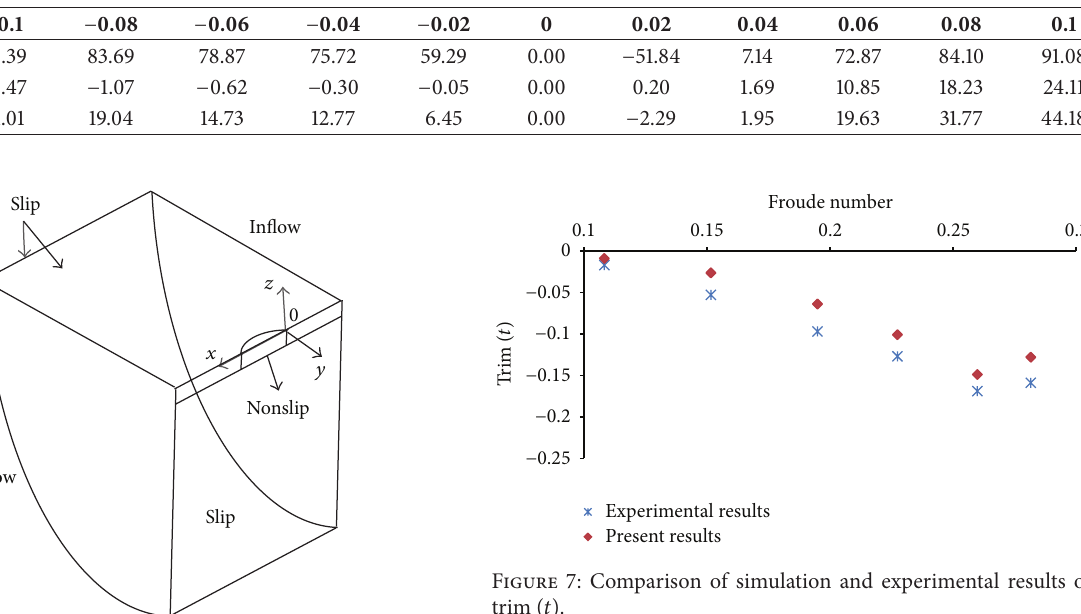
Table 2: Percentage-wise change in wave making and viscous and total resistance due to trim.